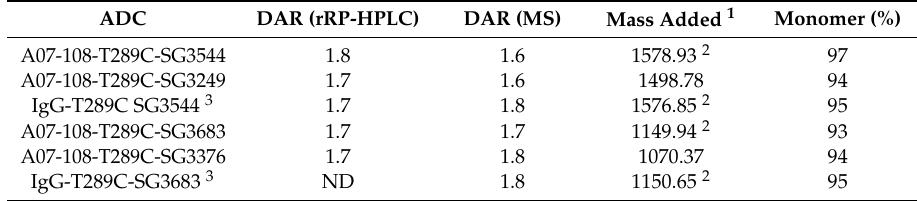
Table 1. Summary of antibody-drug conjugates (ADC) drug content and aggregate analysis.